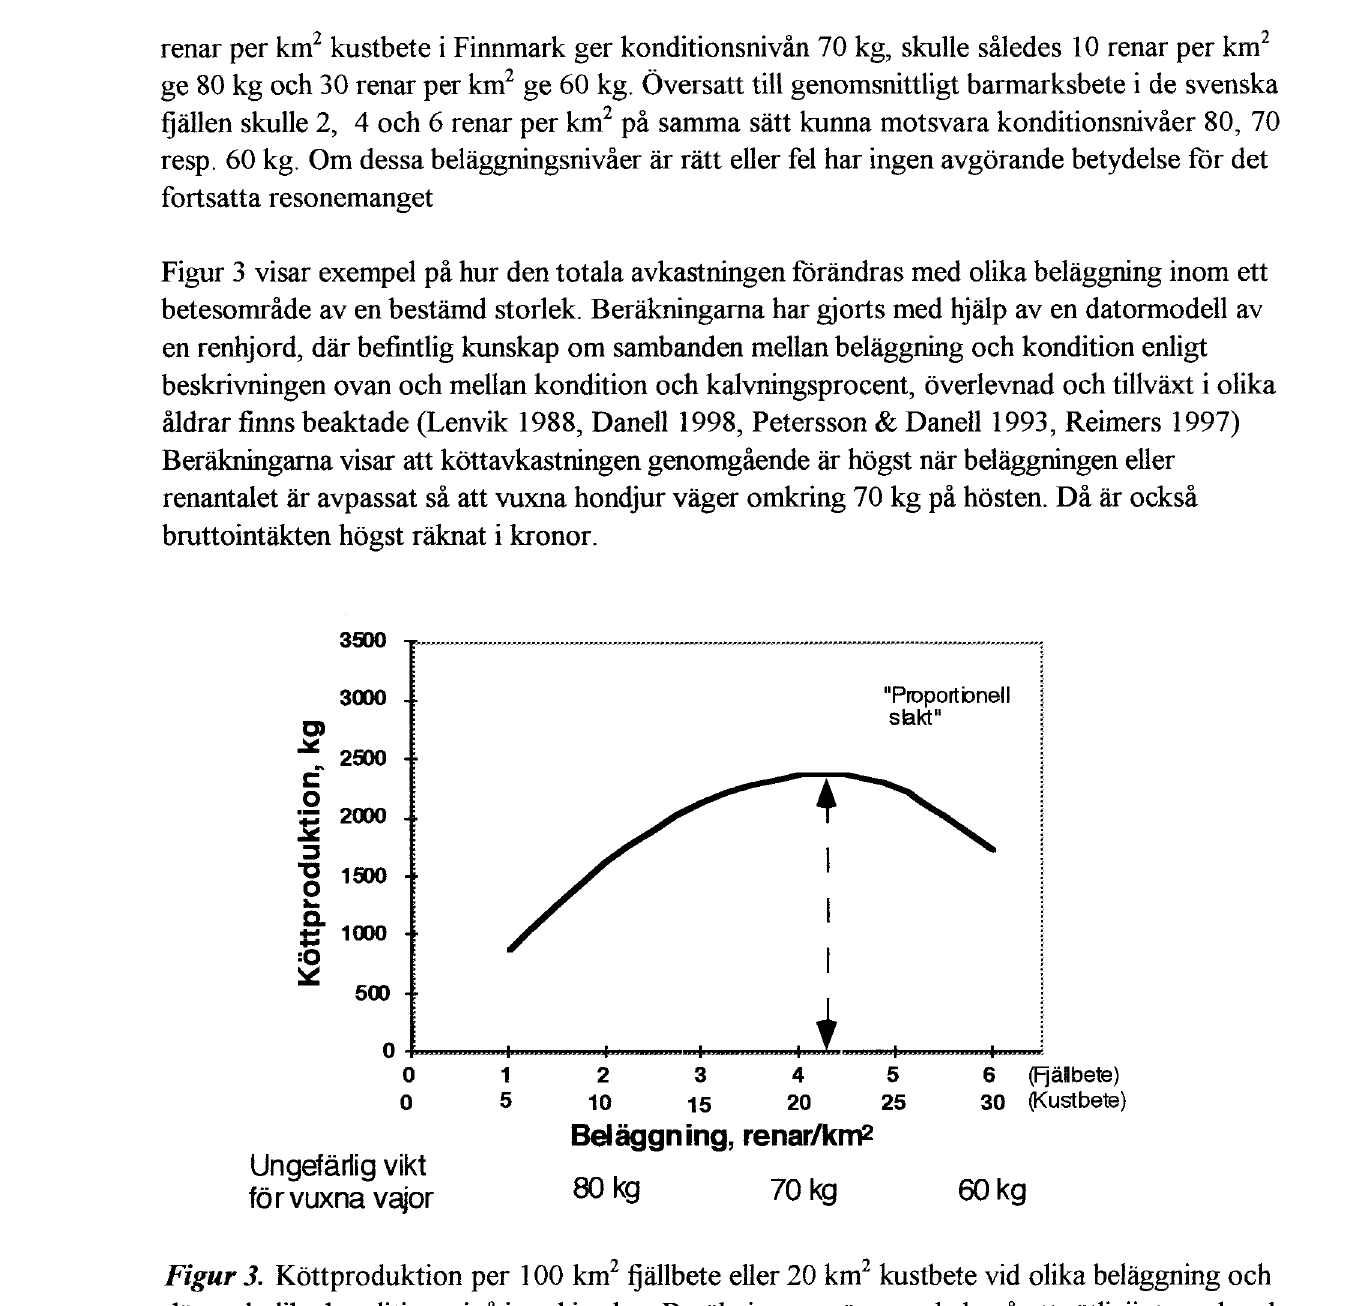
Figur 3. Kottproduktion per 100 km 2 fjållbete eller 20 km 2 kustbete vid olika belåggning och dårmed olika konditionsnivå i renhjorden. Beråkningarna år grundade på ett råtlinjigt